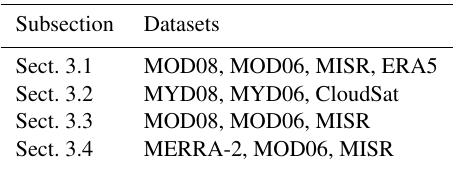
Table 2. The combination of datasets used in each subsection of the Results